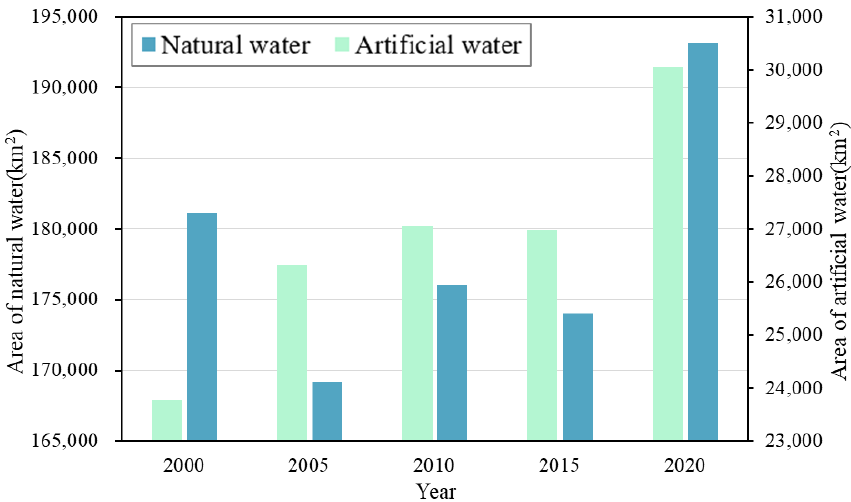
Figure 5. Changes in artificial and natural water bodies in China from 2000 to 2020.